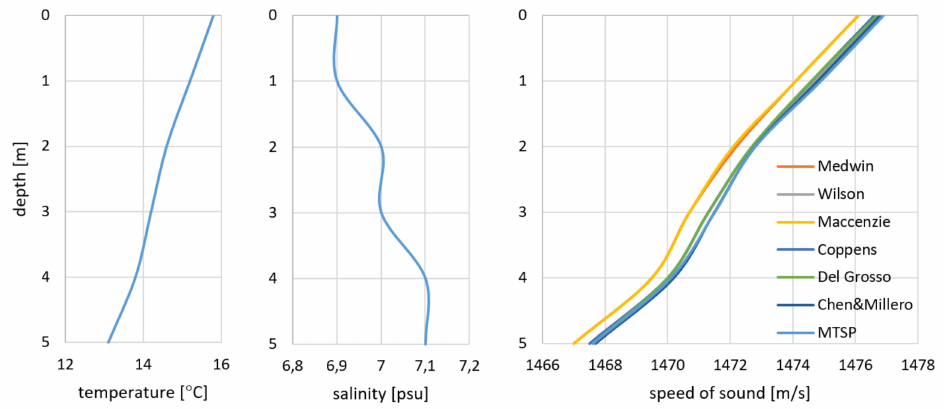
In graphic form, temperature, salinity and sound speed in water profiles in Gdynia are shown in Figure 11.